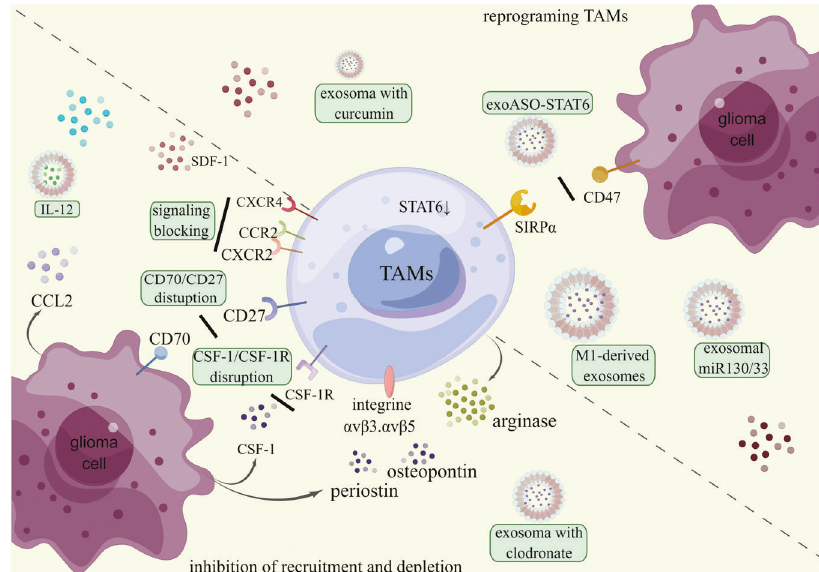
Fig. 4 Current exosome-mediated nano immunotherapies are targeting TAMs. TAMs-targeted therapies are roughly divided into inhibiting recruitment or radically depleting TAMs from the quantity perspective and reprogramming TAMs from the quality standpoint. Exosome presents us with an encouraging nano platform for targeted drug delivery. Glioma cells are the signi fi cant group of cells inducing TAMs recruitment. There are emerging approaches striking to block or disrupt various signaling pathways between TAMs and glioma cells, such as the IL-12, CCL2/CCR2, SDF-1/CXCR4, CD70/CD27, CXCR2, CSF-1/CSF-1R, periostin/integrine α v β 3, osteopontin/integrine α v β 5 signaling. Exosomes loaded with clodronate show considerable effects on depleting TAMs. They block the CD47/SIRP α signaling via exoASO-STAT6 incudes upregulated STAT6, thus reprogramming TAMs to the anti-tumor M1 phenotype. Besides, exosomal miR130, exosomal miR-33, exosome loaded with curcumin, and M1 macrophage-derived exosomes also signi fi cantly re-educate TAMs. Detailed information and additional promising target are discussed as follows. (By